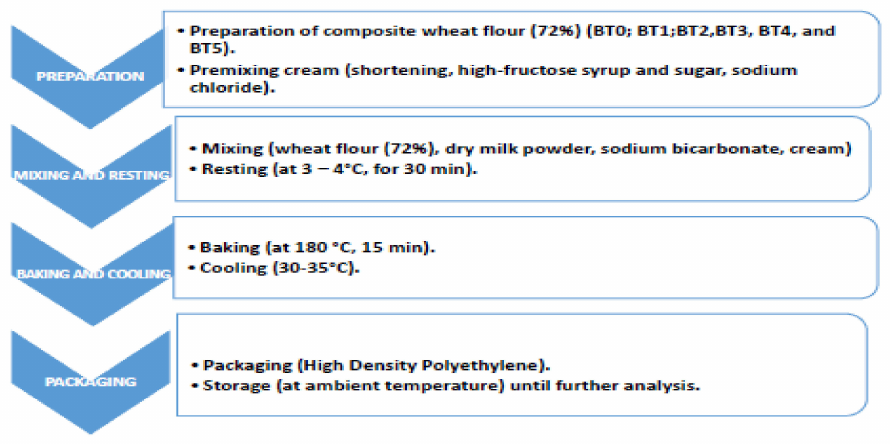
Figure 1. Flowchart of processed